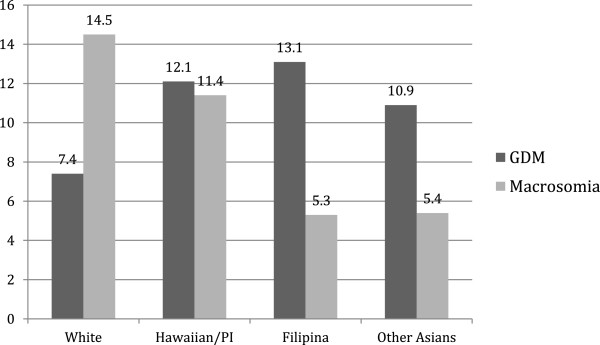
Prevalence (%) of GDM and associated macrosomia by ethnicity.